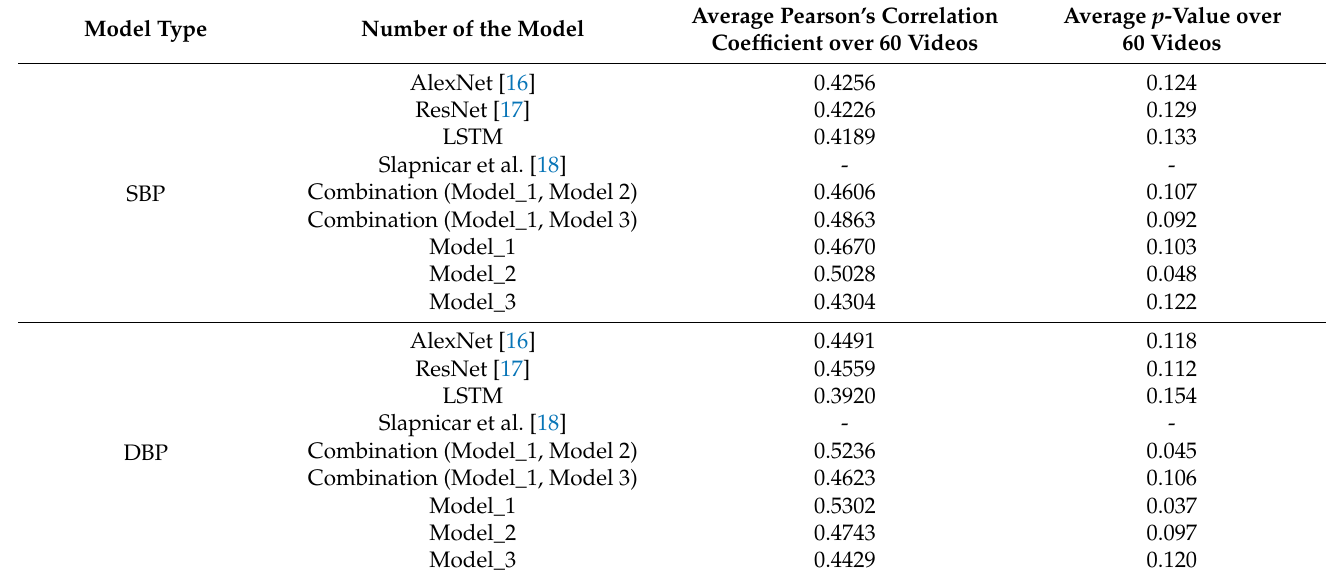
Table 6. Comparison between our models and available pretrained models using Operators dataset. Model